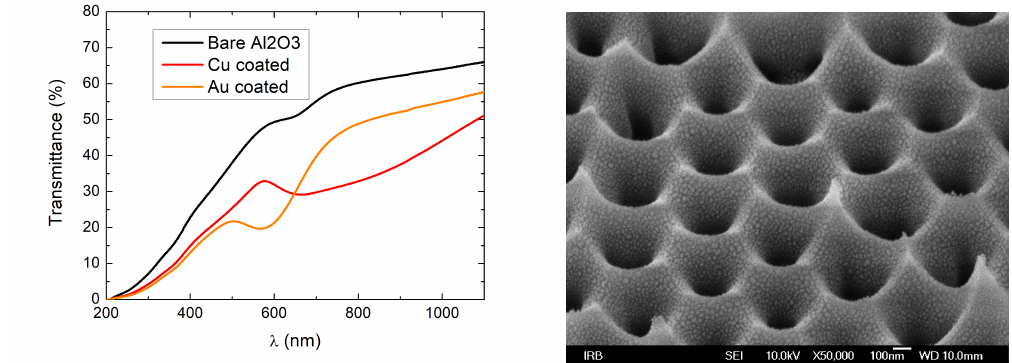
Figure 11. Left: Normal incidence transmittance of Al 2 O 3 before and after the deposition of 9 nm mass thickness Au and 8 nm mass thickness Cu metal island films. Right: Scanning electron microscopy picture of the Au-coated Al 2 O 3